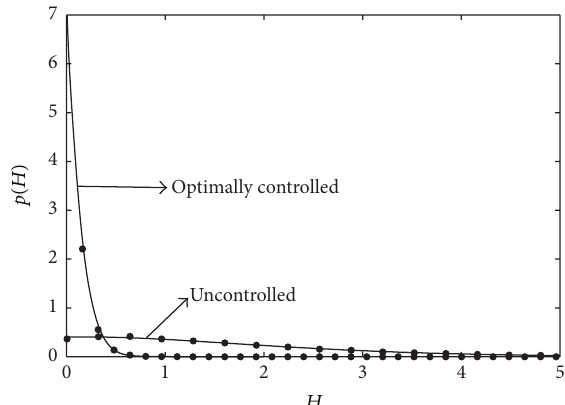
Figure 1: Stationary probability density 𝑝(𝐻) of total energy of uncontrolled and optimally controlled system (28). The lines are obtained from numerical solution of (37) while the dots are obtained from direct simulation of original system